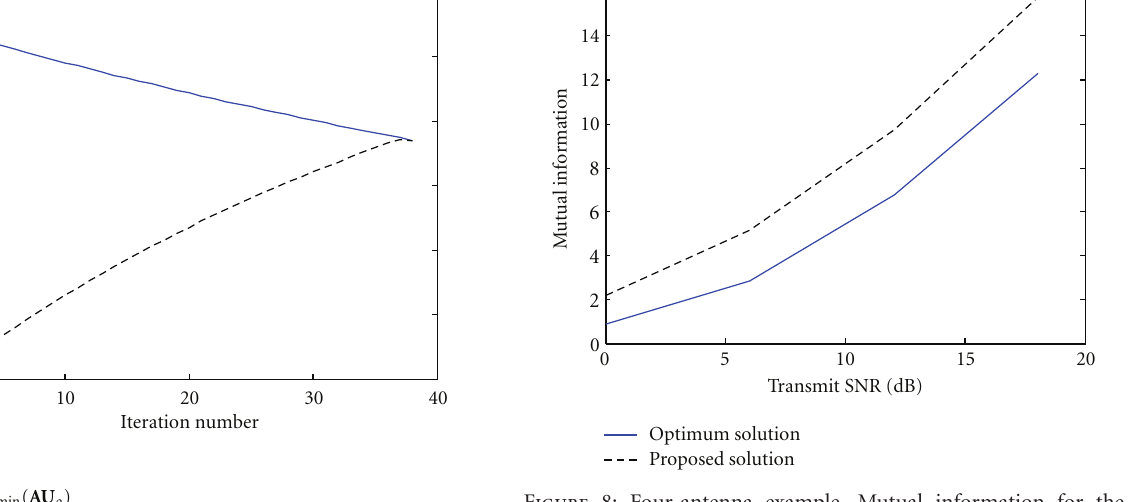
Figure 8: Four-antenna example. Mutual information for the optimum precoder and the proposed precoder.